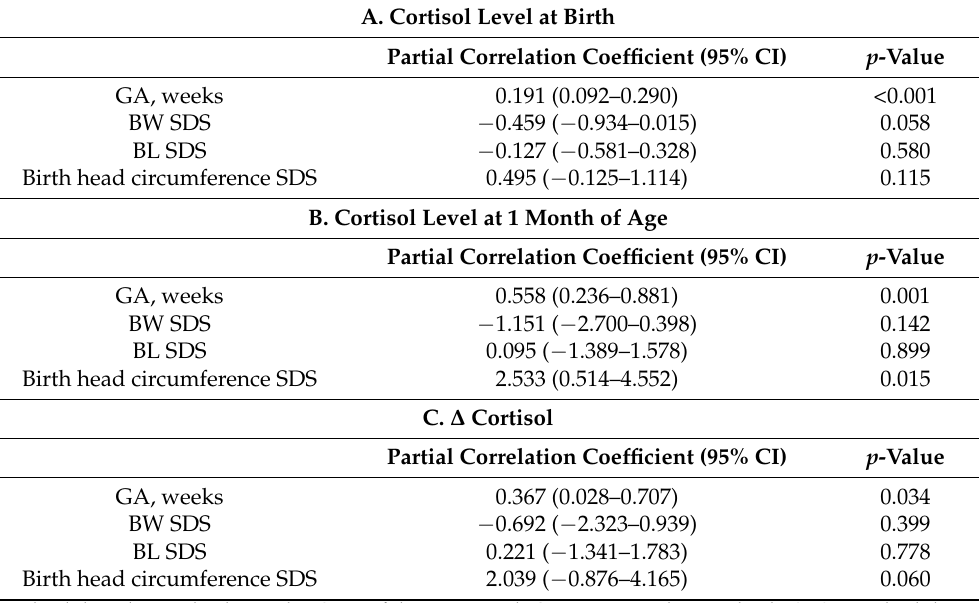
Table 3. Multivariate regression